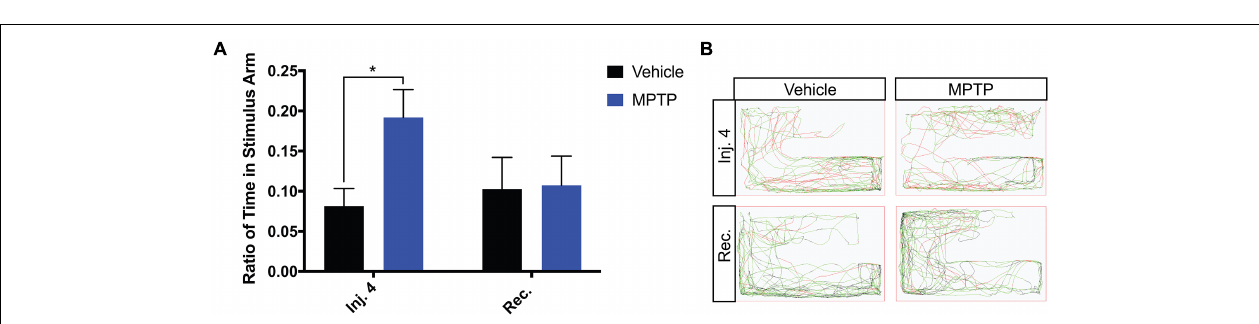
FIGURE 4 | Impact of MPTP on olfactory response in adult zebrafish. (A) Ratio of time spent in the stimulus arm following the fourth injection and 2-week recovery. (B) Respective path images for MPTP injected zebrafish and vehicle controls after the fourth injection and a 2-week recovery. Red lines represent fast movement, green lines represent slow movement and black lines represent inactive movement below the slow threshold. Bars represent the mean ± the SEM. * p < 0.05.